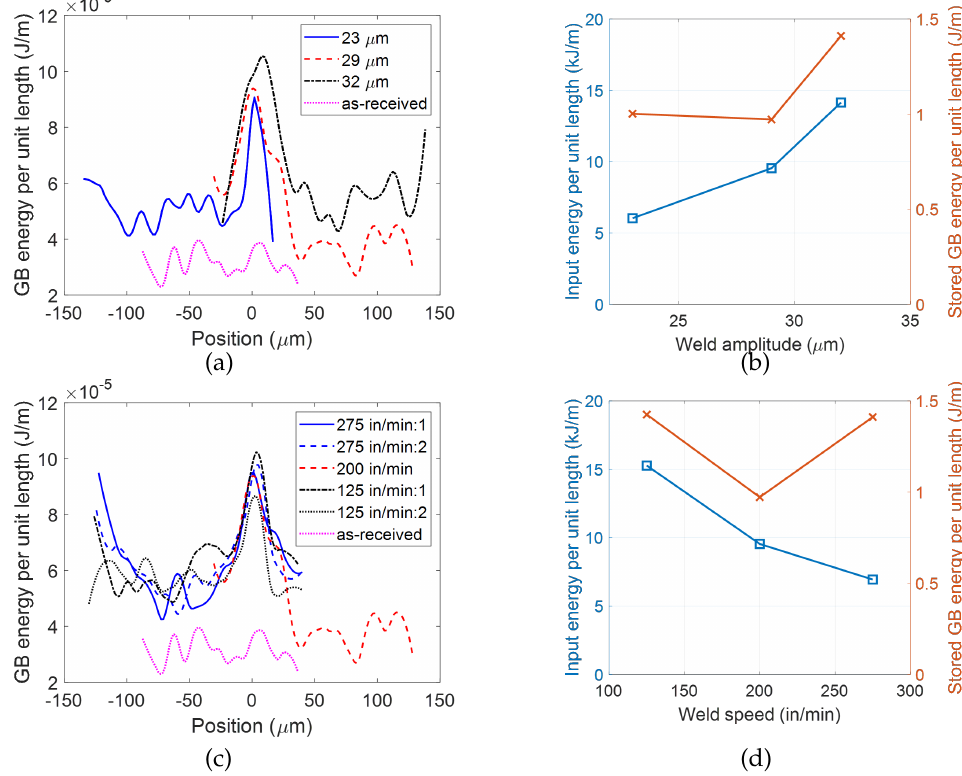
Figure 14. Trends in the stored energy in the microstructure with the weld parameters used for UAM fabrication: ( a ) stored energy map for the control vs. samples prepared using 23, 29, and 32- µ m weld amplitudes; ( b ) total stored energy in the microstructure per unit length compared against the input electrical energy per unit length of weld as a function of weld amplitude; ( c ) stored energy map for the control vs. samples prepared using 52.91, 84.67, and 116.41 mm/s (125, 200, and 275 in/min) weld speeds; ( d ) total stored energy in the microstructure per unit length compared against the input electrical energy per unit length of weld as a function of weld